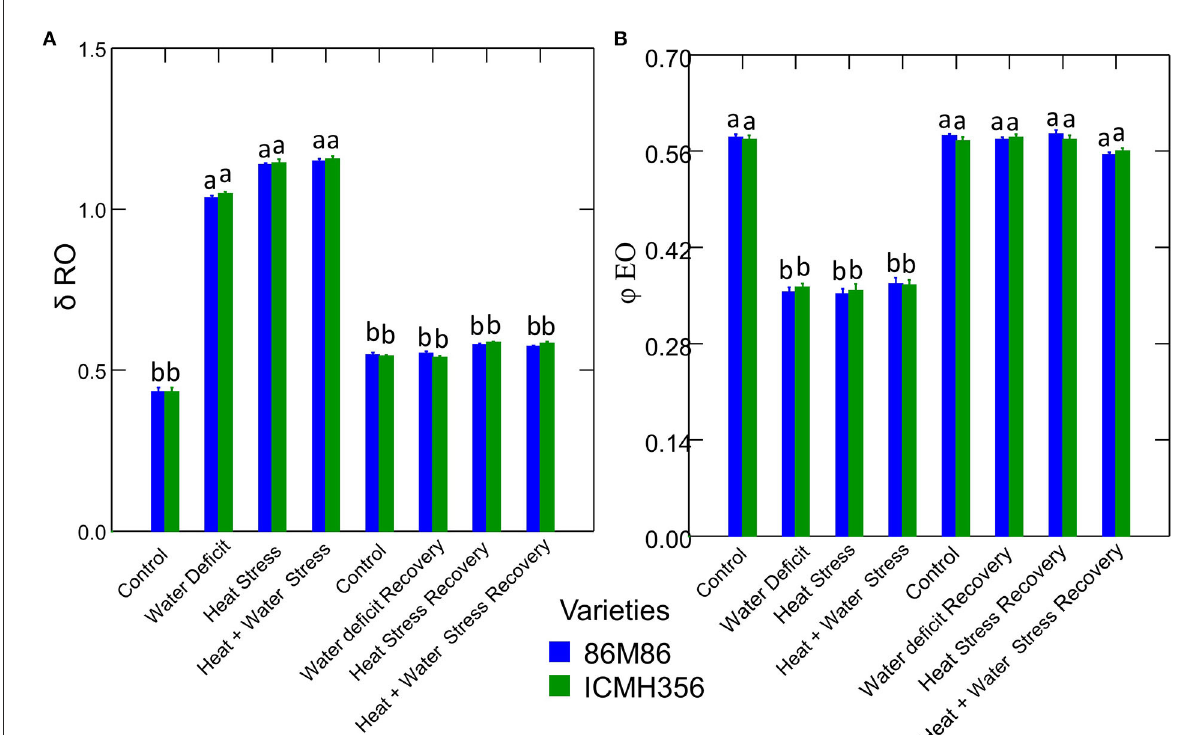
FIGURE7 Electron transport efficiency δ RO (A) and probability φ EO (B) parameters in two varieties of pearl millet under water-deficit stress and heat stress in isolation and in combination and at recovery from stress (B) . Bars represent SE. Letters indicate significance at 0.05, and different letters indicate significant difference between